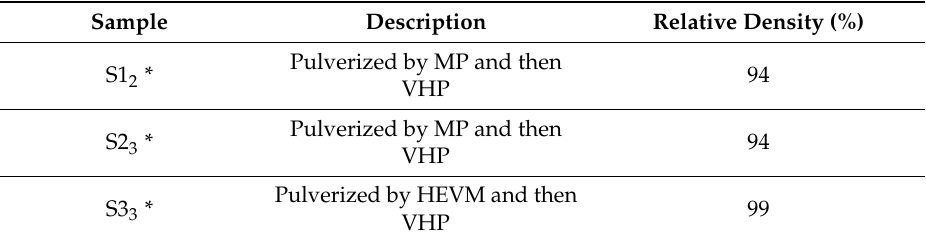
Table 1. Relative densities of the VHPed samples under di ff erent pulverization